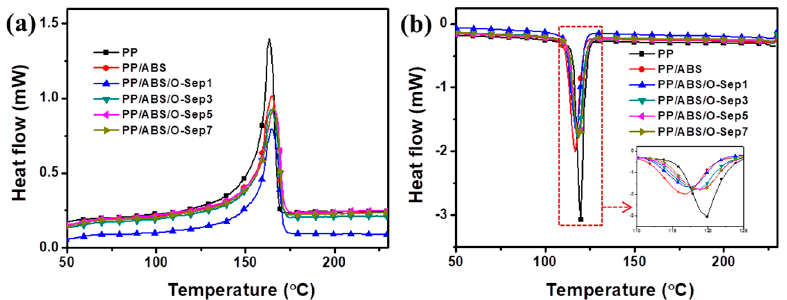
Figure 4. DSC traces of PP and PP/ABS/O-Sep nanocomposites: ( a ) second heating scans, ( b ) first cooling scans.